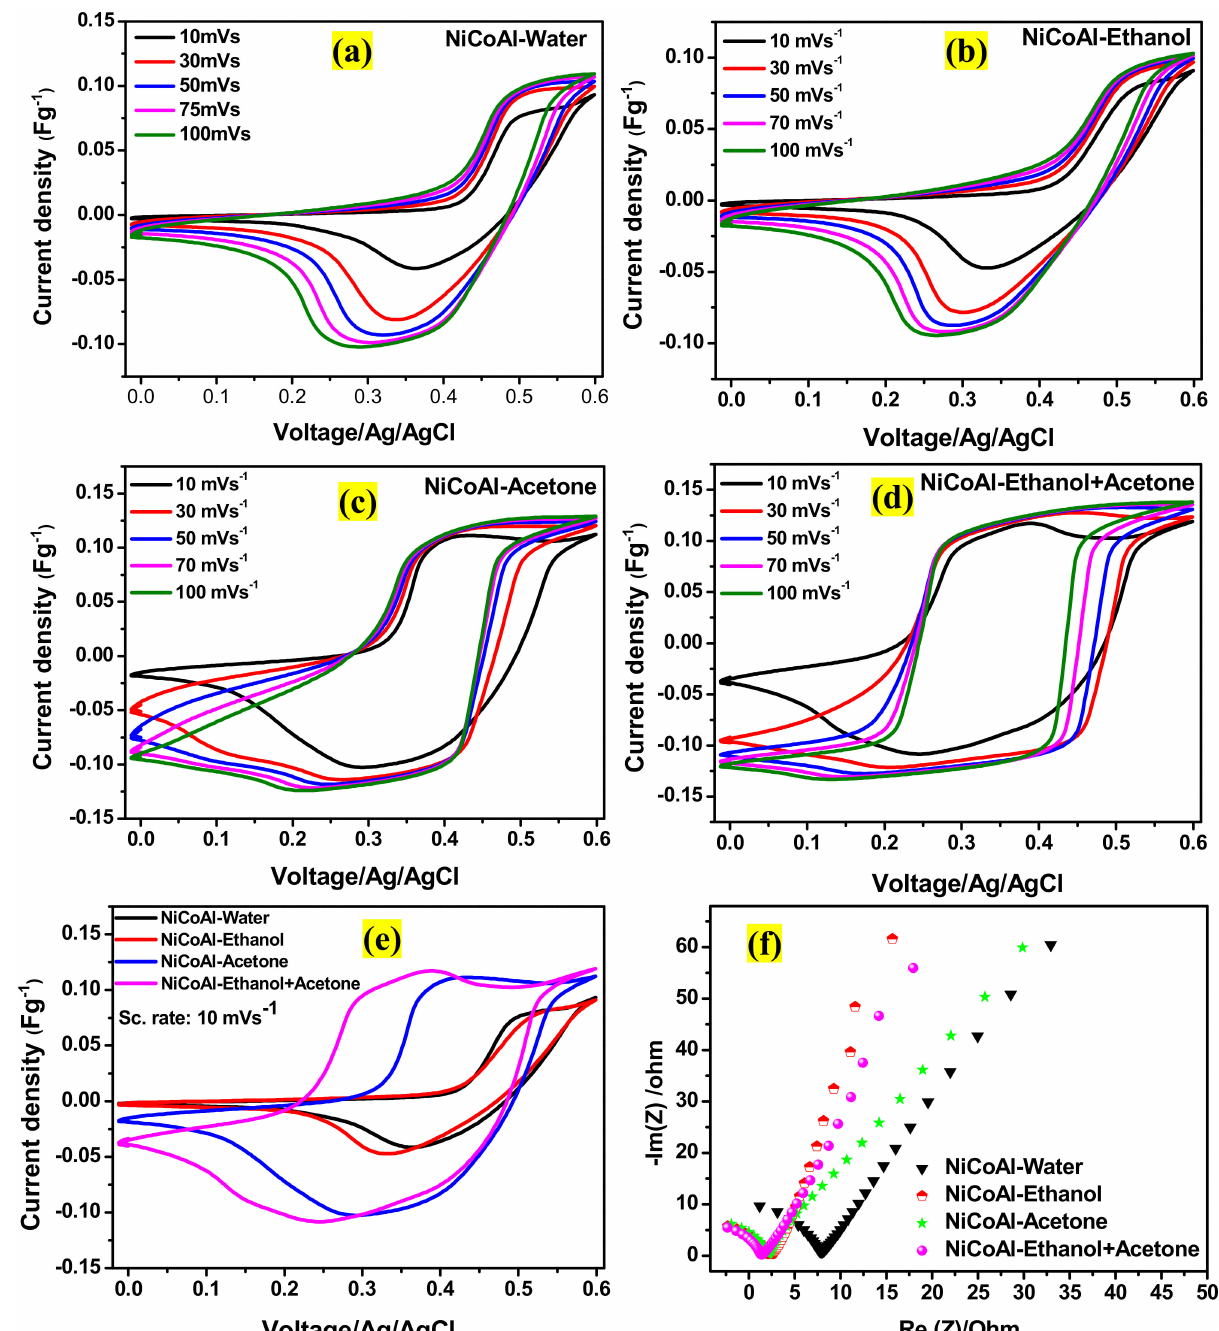
Figure 5. CV curves with various scan rates of ( a ) NiCoAl-Water, ( b ) NiCoAl-Ethanol, ( c ) NiCoAl- Acetone, and ( d ) NiCoAl-Ethanol + Acetone. ( e ) Comparative CV curves of samples at 10 mV/s. ( f ) Comparative Nyquist plots of